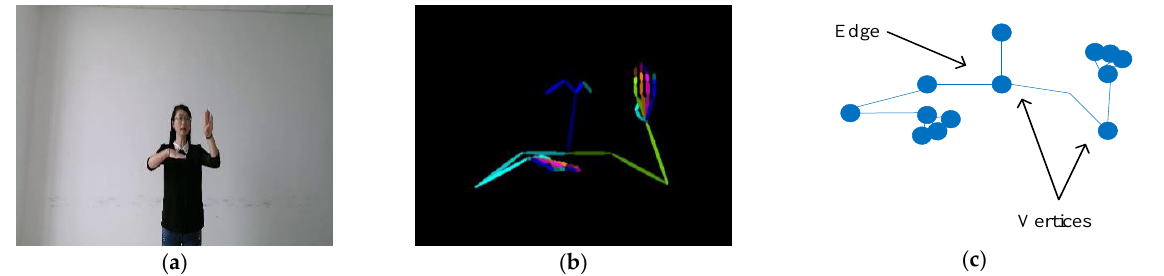
Figure 1. ( a ) The t -th RGB frame; ( b ) The skeleton data extracted from RGB frame; ( c ) schematic diagram of graph data.